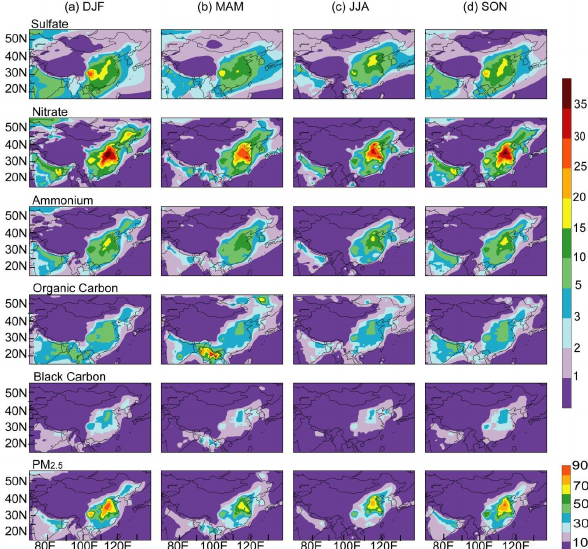
Figure 2. Simulated seasonal mean surface-layer concentrations (µgm − 3 ) of sulfate, nitrate, ammonium, OC, BC, and PM 2 . 5 in AN- Nmet averaged over 2004–2012.